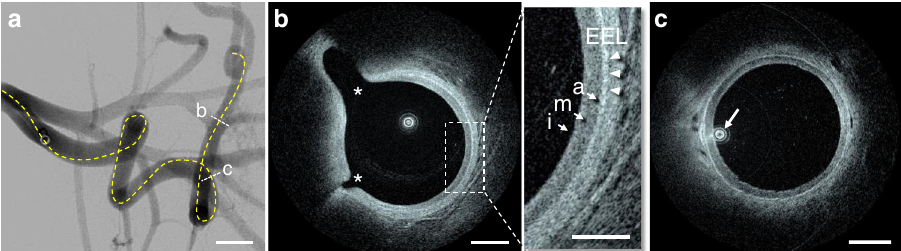
Fig. 2 In vivo imaging in a fl exed forelimb model of brachial porcine artery. a The dotted line highlights the estimated path taken by the Vis-M device through the vessel tortuosity. b HF-OCT microscopy shows the external elastic lamina (arrowheads) and the individual layers of the vessel wall (arrows). A bright tunica intima is followed by a dark tunica media and a bright adventitia (inset). The asterisks denote the ostia of two side-branches, with diameters of ~0.2 and 0.7 mm, respectively. c The arrow indicates the eccentric position of the HF-OCT device in the arterial lumen. The image shows a uniform illumination and absence of NURD artifacts. Imaging in a fl exed forelimb swine model was repeated in a total of n = 16 arteries from all animals included in this study ( n = 8). The scale bar on DSA image is equal to 1 cm ( a ). HF-OCT images scale bars are equal to 1 mm ( b and c ), and 0.5 mm in the inset.